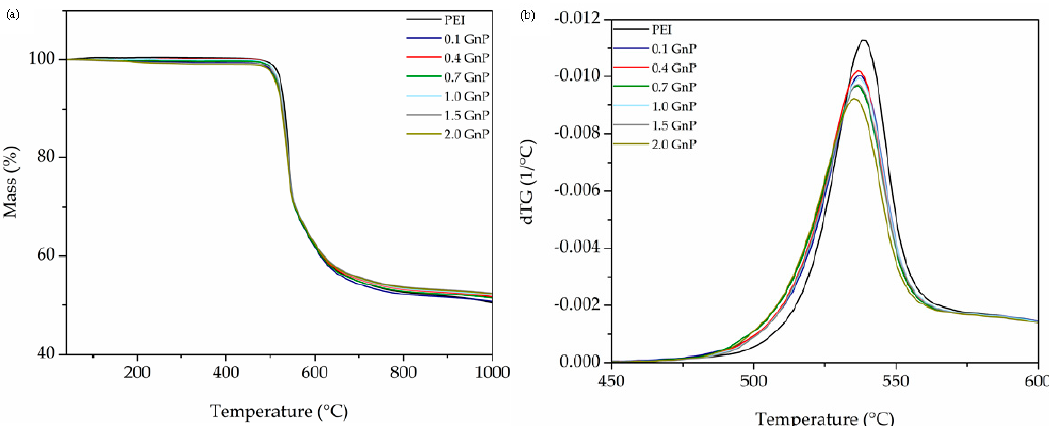
Figure 5. ( a ) TGA and ( b ) dTG thermograms of pure PEI and PEI-GnP nanocomposite foams. Table 3. TGA results of pure PEI and PEI-GnP nanocomposite foams.